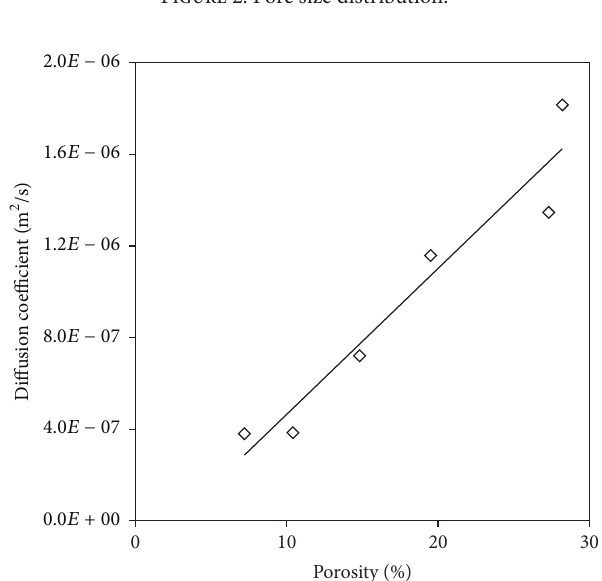
Figure 4: Diffusion resistance factor of sandstones as function of porosity.